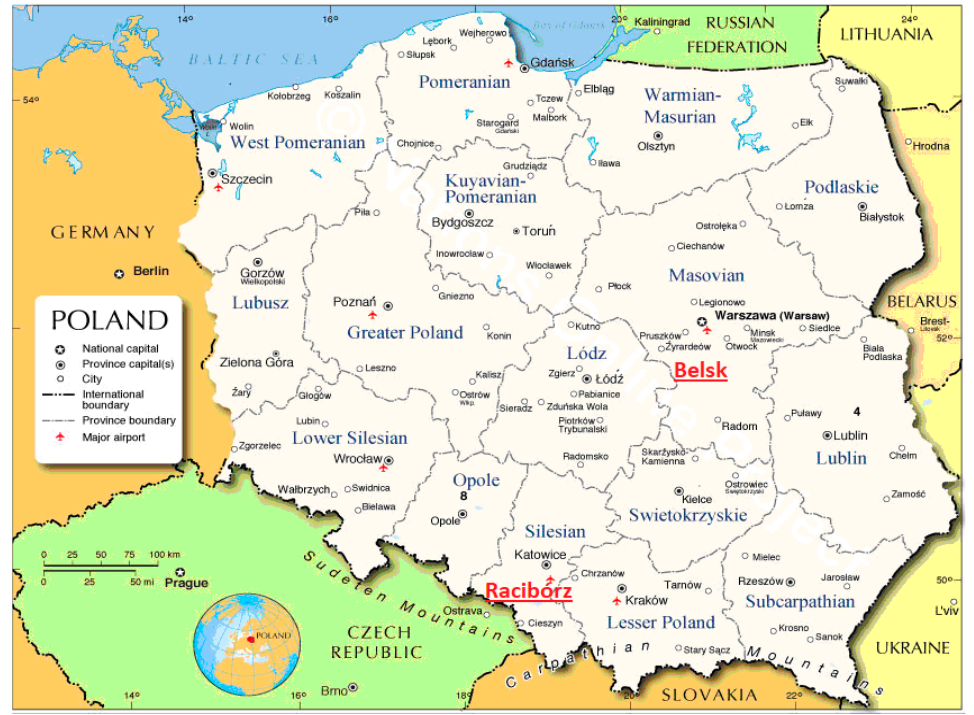
Figure 1. Location of the stations considered in the study. (source: nationsonline.org). Table 1. Characteristics of the stations.